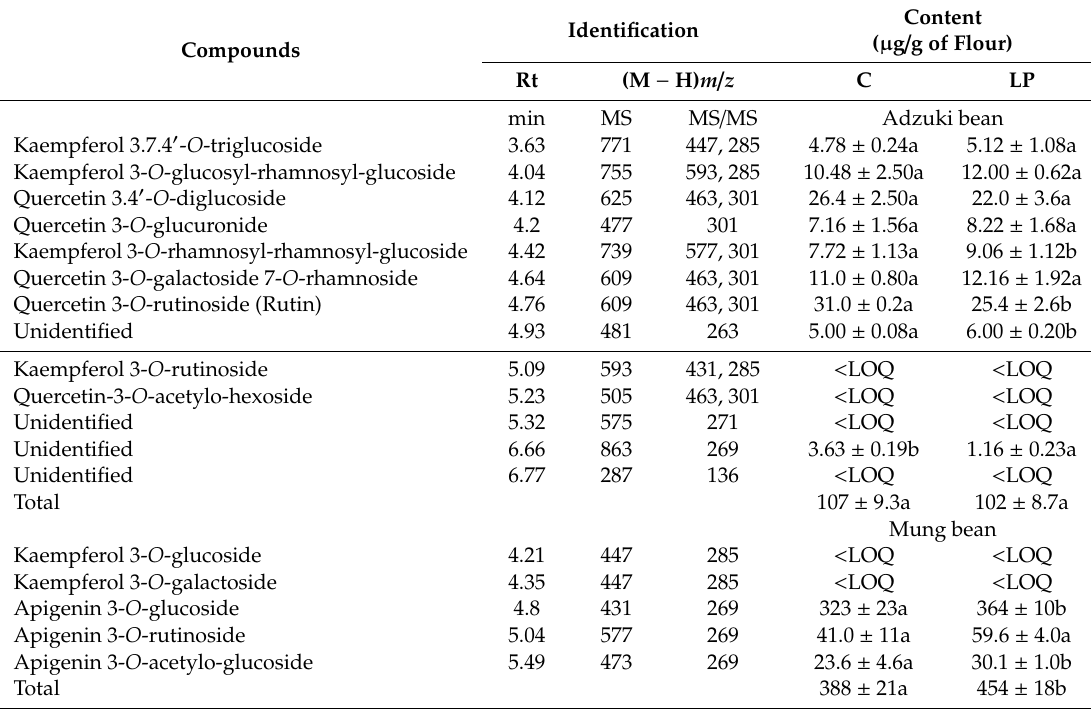
Table 1. Individual phenolic content in the fraction obtained after the simulated gastric digestion of the control and probiotic-rich adzuki bean and mung bean sprouts.